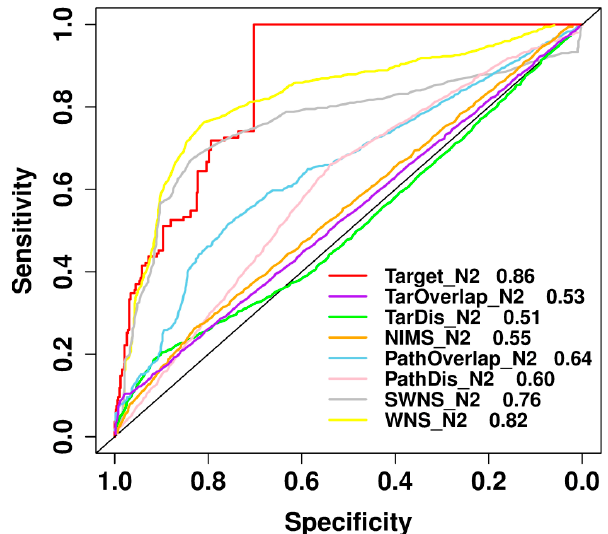
Figure 7. Performance comparison between our proposed method and Chen et al.’s method by using the leave-one-out cross validation test [12]. The red line shows the classification performance of our method while the others show the performances of Chen et al.’s models.